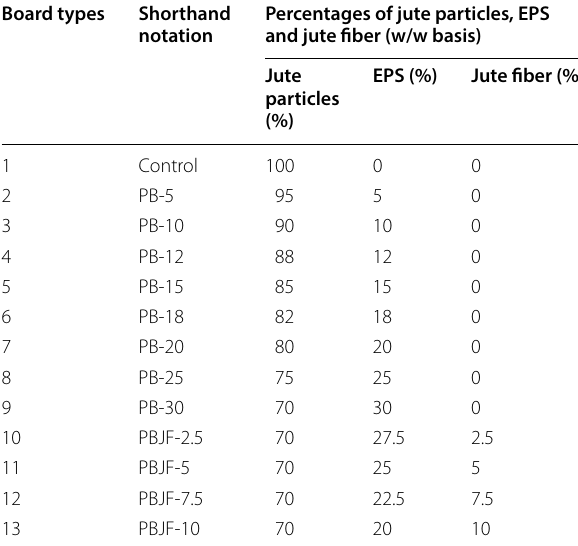
Table 2 Ratios of reinforcing materials for the fabrication of different types of